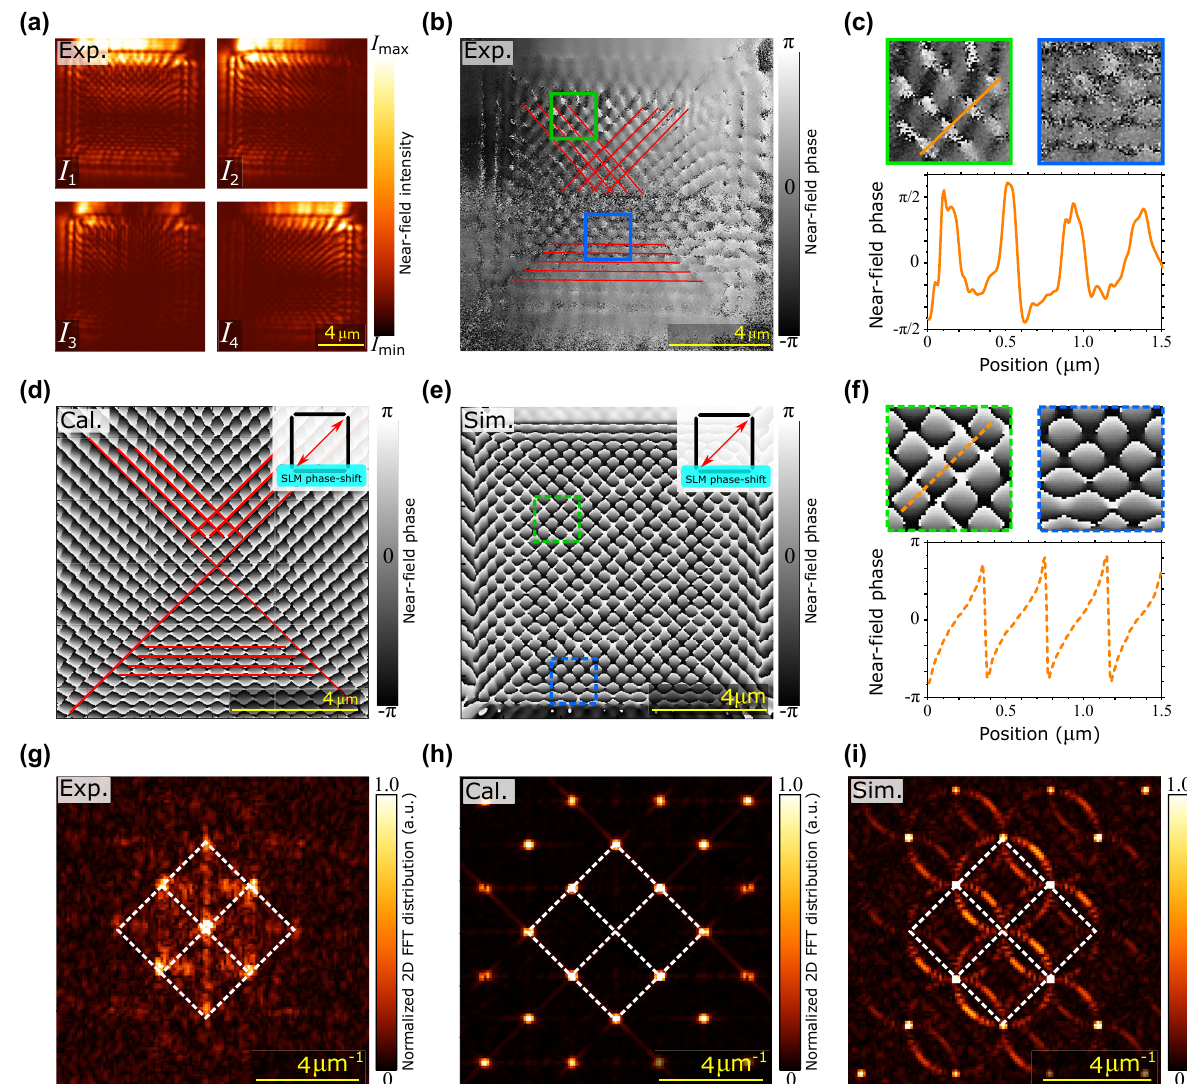
Figure 2: Near-field phase distribution on square SPID. Square SPID with left, upper, and right slit producing OBJ wave and bottom slit producing REF wave: (a) Near-field intensity recorded by SNOM for four phase shifts of the REF wave. (b) Experimentally obtained phase distribution. (c) Details from (b) and linear phase profile. Corresponding areas in (b) and (c) have colour-matched frames; the linear profile is taken along the orange line. (d) Analytical model and (e) FDTD numerical simulations of the phase distribution (f) Details from (e) and linear phase profile. Inset in (d) and (e) shows an arrangement of the slits with the turquoise patch representing the area with a modified phase serving as the source of the REF wave and the red double-sided arrow showing the direction of polarization. (g)–(i) FT of (b)–(e),